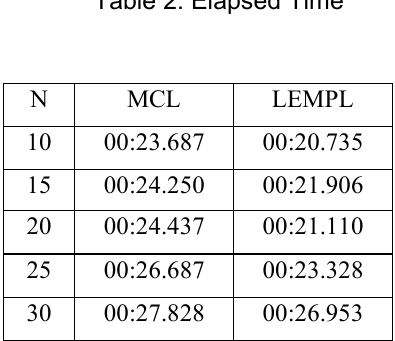
Figure 6. Effect of Increase in Anchor density over Localization Error